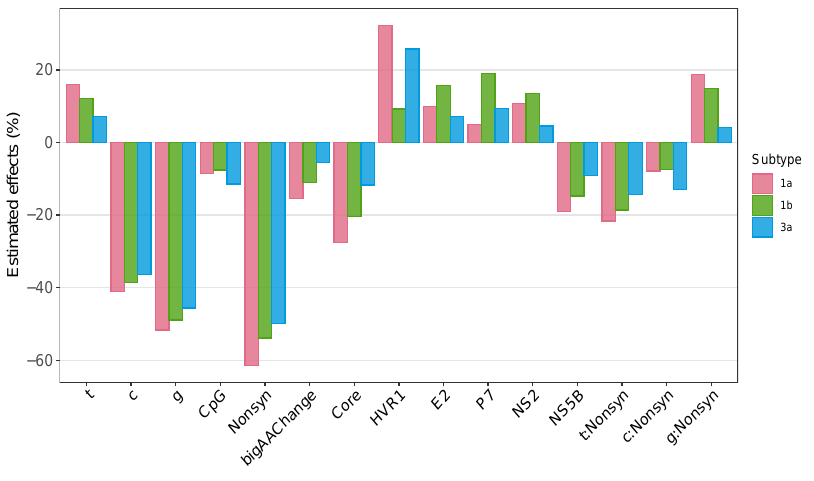
Figure 6. Effects of various factors on mutation frequencies estimated using beta regression. Predicted effect sizes of ancestral nucleotide (t, c, or g vs. a); CpG-creating status (CpG; vs. non-CpG-creating status); nonsynonymous (Nonsyn; vs. synonymous); drastic amino acid-changing status (AAChange; vs. non-drastic amino acid-changing); genomic locations (Core, HVR1, E2, P7, NS2, NS4A, and NS5B; vs. the NS3/NS4B/NS5A regions) on mutation frequencies in the HCV genome. The figure reflects the result of the best-fit model based on AIC from the beta